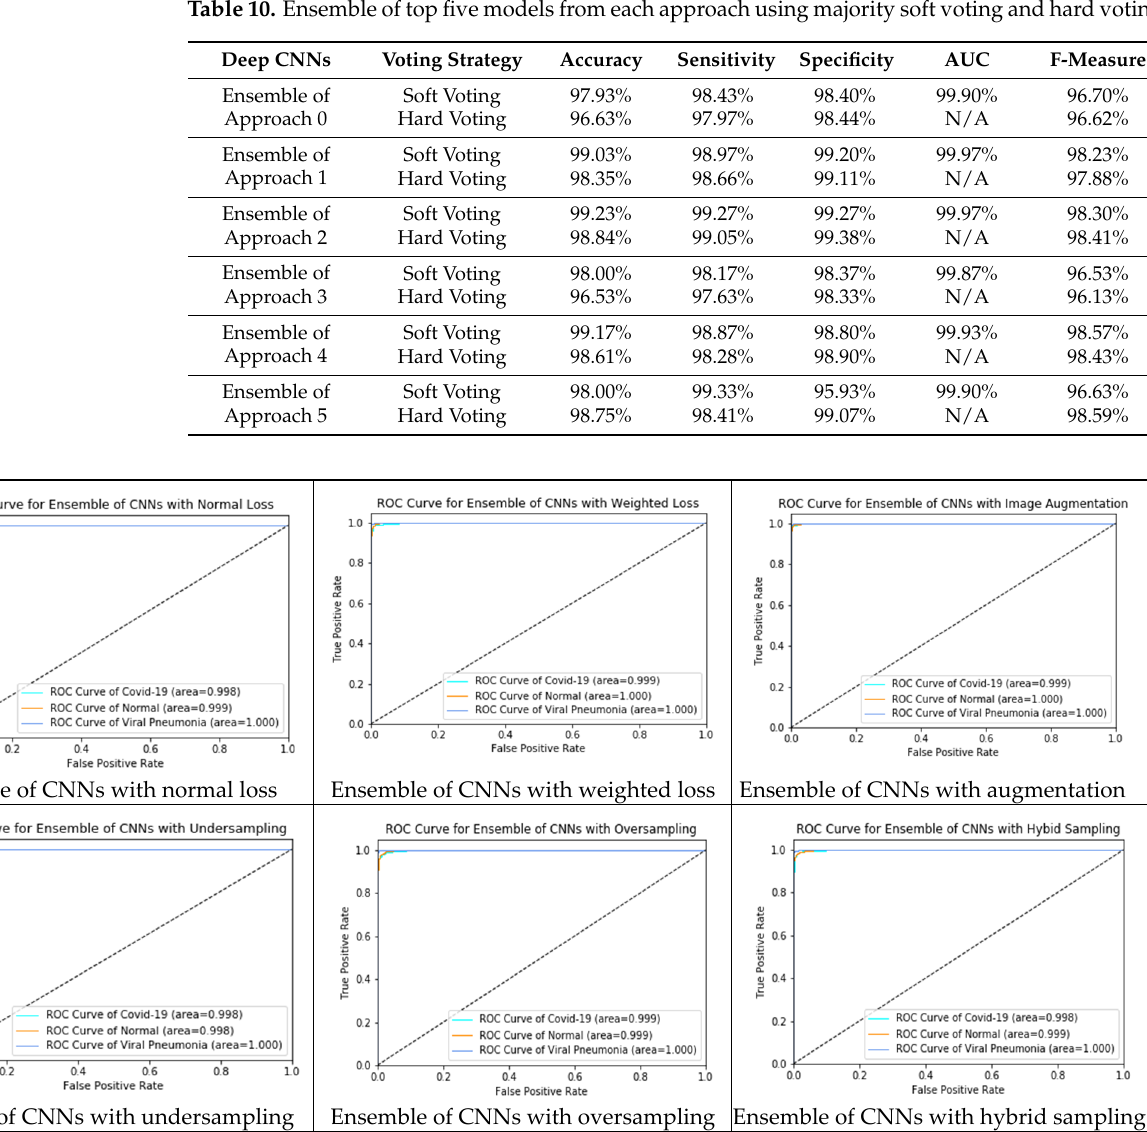
Figure 16. ROC curves (true positive rate vs. false positive rate) of each ensemble classifier.